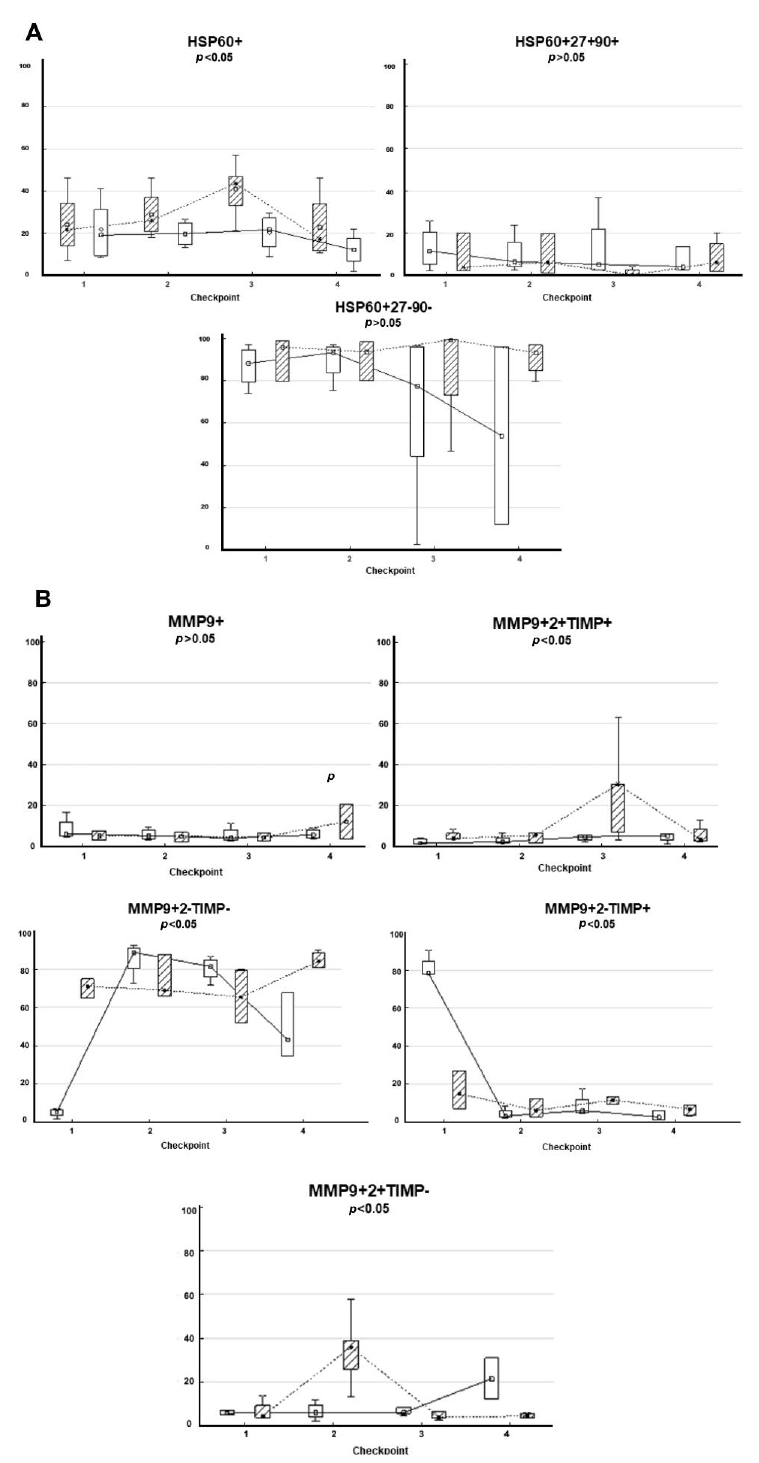
Figure 4. HSPs and MMPs composition at the surface of CD9-positive sEVs of RCPs depending on the effectiveness of thermoradiotherapy. ( A ) HSP and ( B ) MMP composition on CD9-positive sEVs of RCPs depending on the effectiveness of thermoradiotherapy. The dotted line and shaded boxes correspond to partial tumor response and stabilization; the solid line and light boxes are complete tumor responses. The median, 25–75 quartiles, and p -level are presented. The x-axis shows checkpoints for monitoring patients during which blood was taken for sEVs isolation. The y-axis is presented as a percentage of the sEVs subpopulation in blood